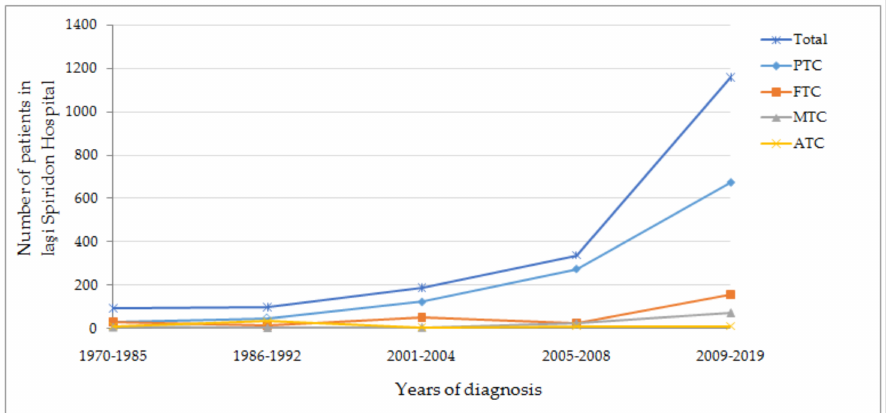
Figure 4. Thyroid carcinoma’s evolutionary timeline before Cernobyl fallout and after nuclear exposure. Combined results of Mogos et al. (1970–1992), Buzduga et al. (2001–2008) and our results. The period of 1993–2000 is missing from this figure [15,16]; PTC—papillary thyroid carci- noma, FTC—Follicular thyroid carcinoma, MTC—medullary thyroid carcinoma, ATC—anaplastic thyroid